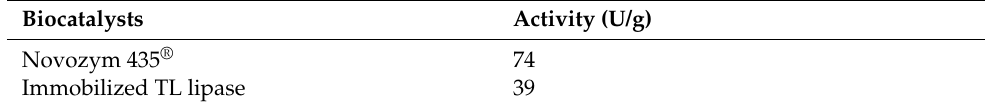
Table 1. Synthesis activity of